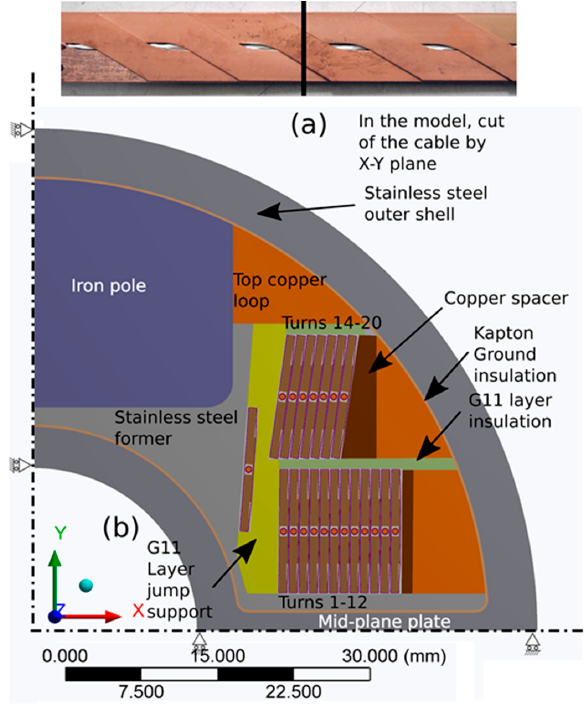
Figure 17. ( a ) Roeble cable used to wind the coils; black line indicates the cable section as it ap- pears in the bottom picture. ( b ) One quarter cross-section of the AB FeatherM2 dipole (courtesy of J. van Nugteren and J. Murtomaki, CERN). The midplane steel connecting the inner and outer shell to control stresses at 18 T is indicated.